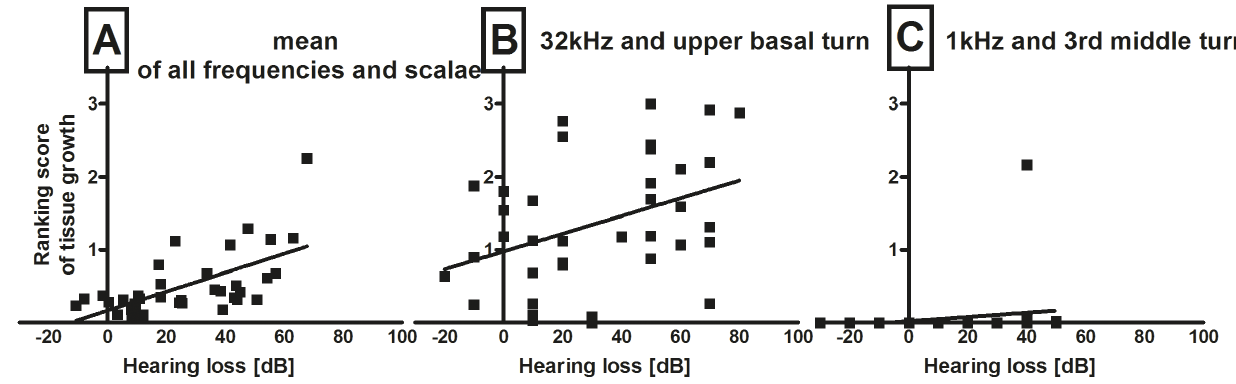
Figure 7. Correlation of hearing loss measured on day 28 and tissue reaction determined by ranking. Graph A illustrates that with the amount of tissue reaction evaluated over the whole cochlea length the loss of residual hearing in all frequencies increases (p , 0.001; r=0.6338). This effect is detectable in lower and higher frequency regions of the cochleae as well. In figure 7B the detected tissue reaction and hearing loss at the upper basal turn and at 32 kHz are plotted as an example for the correlation in higher frequency areas (p , 0.05; r=0.3742). Fig. C is an example for correlation of tissue reaction and hearing loss in lower frequency areas of the cochlea. Here we correlated hearing loss at 1 kHz and tissue growth in the 3 rd middle turn (p , 0.05; r=0.3727).